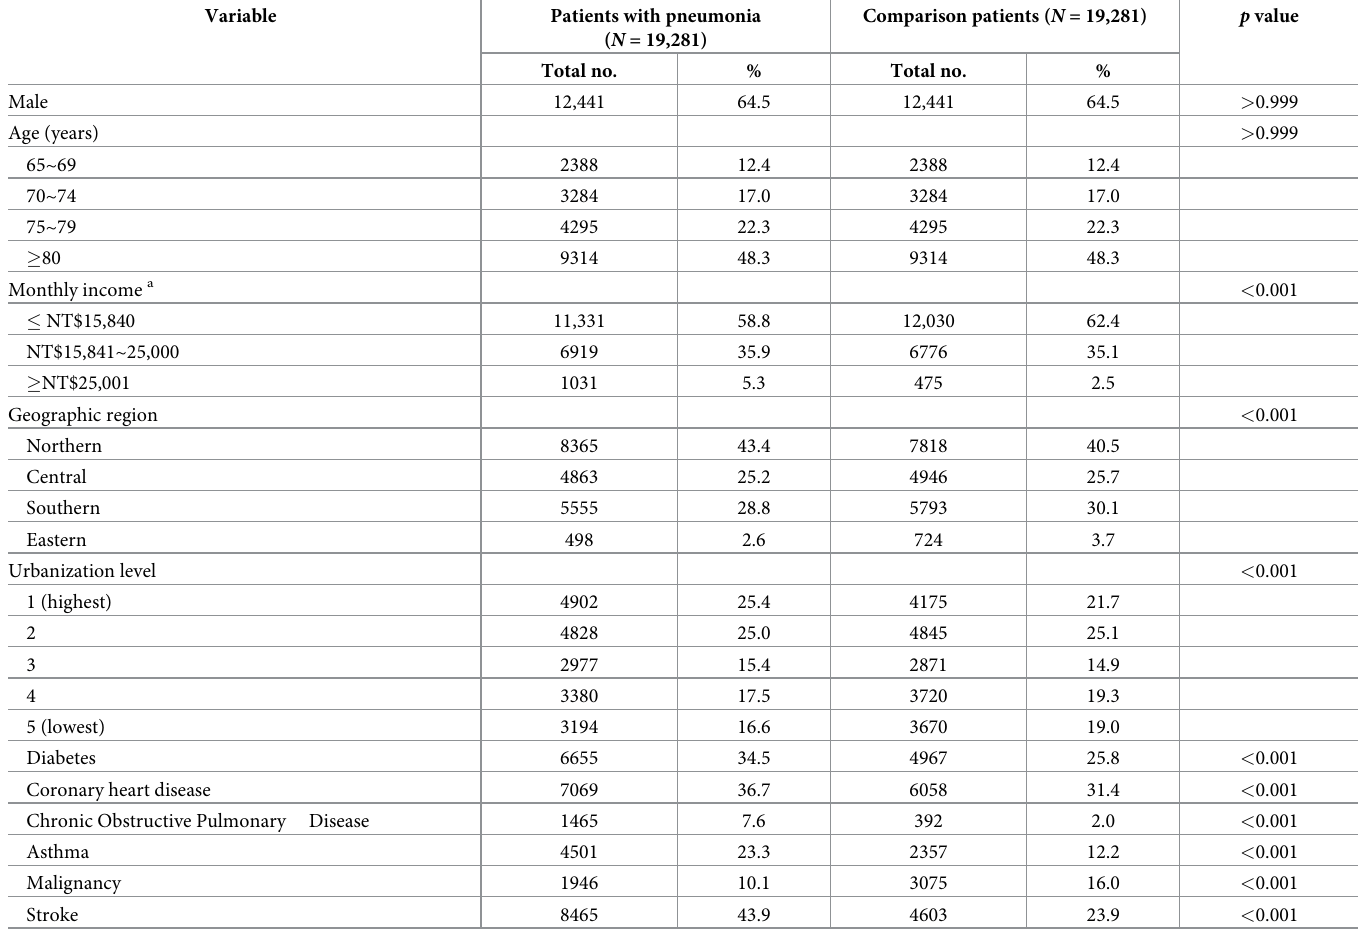
Table 1. Demographic characteristics of patients hospitalized for pneumonia and comparison patients.